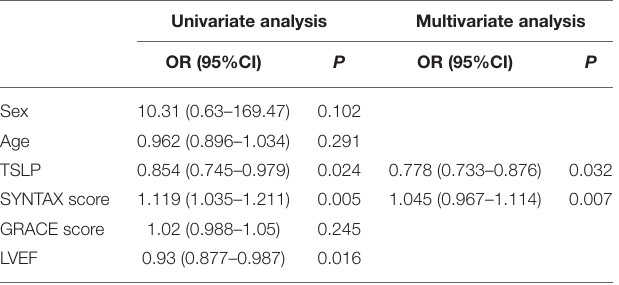
TABLE 4 | Univariate and multivariate logistic regression analysis to evaluate TSLP in predicting MACE in AMI patients. Univariate analysis